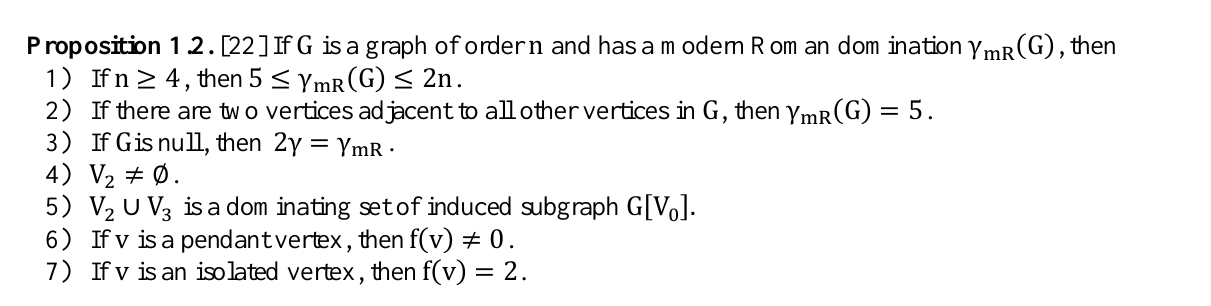
Figure 3: Modern Roman